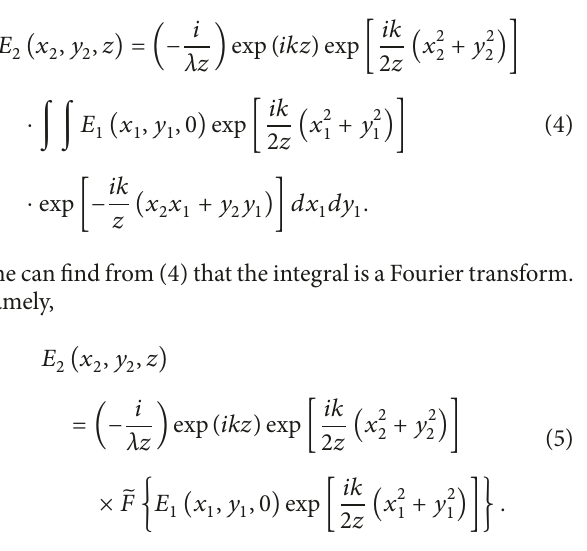
𝑥 , 𝑦 2 2 are the transverse coordinates in the source plane